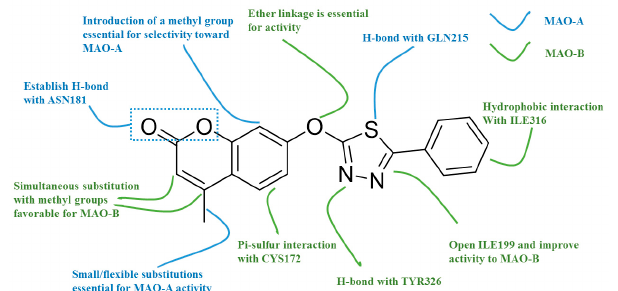
Figure 5. Structure-activity relationship (SAR) / structure-selectivity relationship (SSR) profiles for the coumarins against h MAO subtypes based on compound M43 .